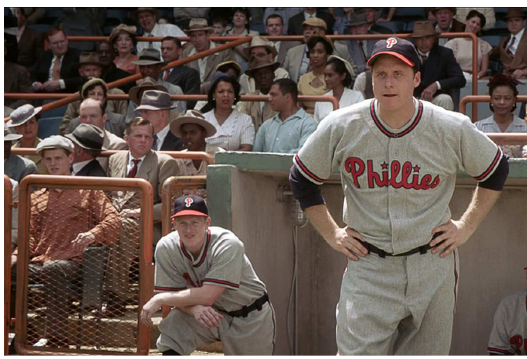
Figure 2: Representation of White’s racial abuse by Ben Chapman (Philadelphia Phillies’ coach) towards Jack Robinson when he was up to